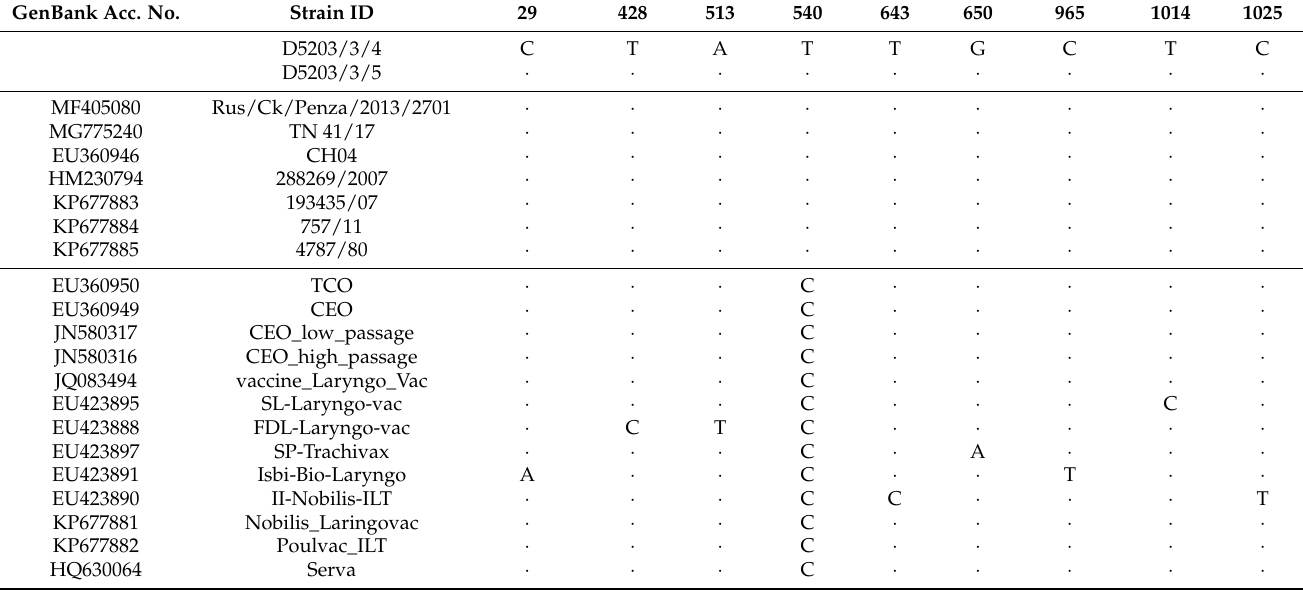
Table 2. Summarized results of the positions of nucleotide changes according to Neff et al., 2008 [16]. Dots represent positions identical to the D5203/3/4 sequence, nucleotide bases of the DNA are represented by A (adenine), C (cytosine), G (guanine) and T (thymine). GenBank Acc.